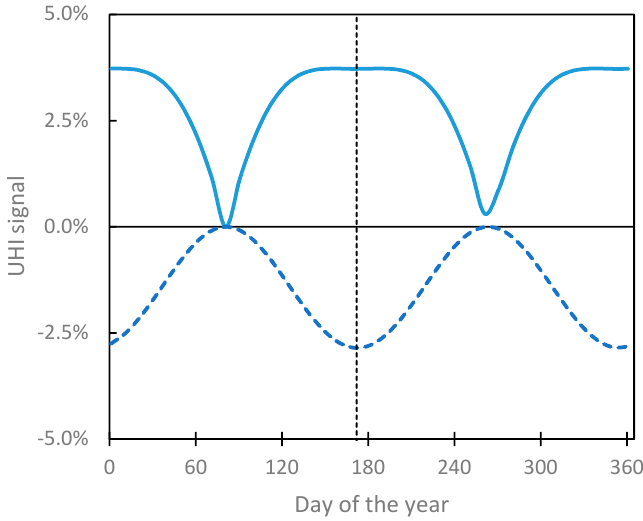
Figure 5. Irradiance balance or UHI signal for PV facades for the scenarios with a bright road (solid line) and a dark road (dashed line) as a function of the day of the year for α r = 30%; α PV = 10%; α w = 70%; α g = 30% (bright road) or g = 0% (dark road). The dotted vertical line indicates the summer solstice. PV efficiency assumed: 20%.